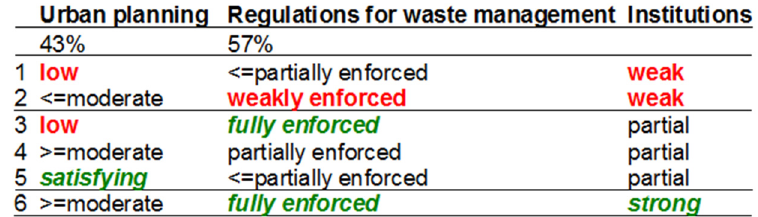
Figure A5. Utility function of the aggregated attribute Social Forces.